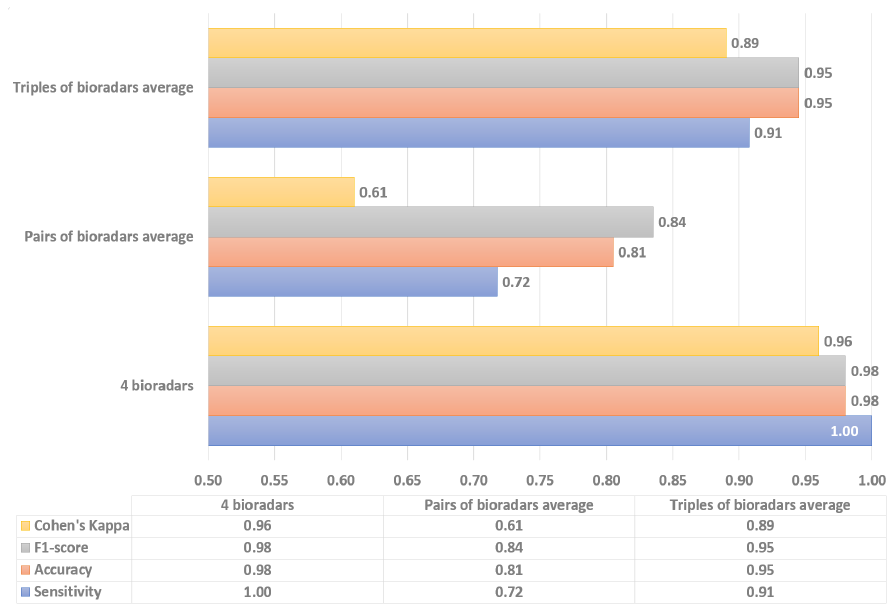
Figure 11. Overall comparison of the system